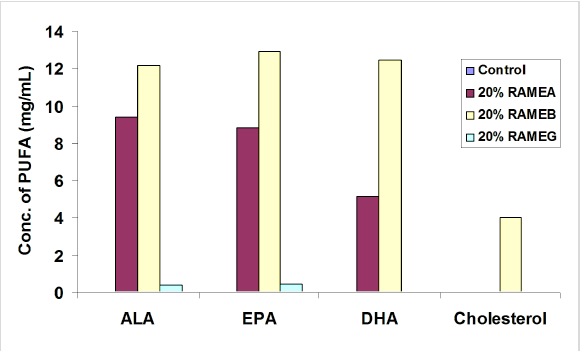
Figure 3: Solubility of n − 3 PUFAs and cholesterol in water solutions of 20% randomly methylated α -, β - and γ -CDs (RAMEA, RAMEB and RAMEG) compared to distilled water (control).